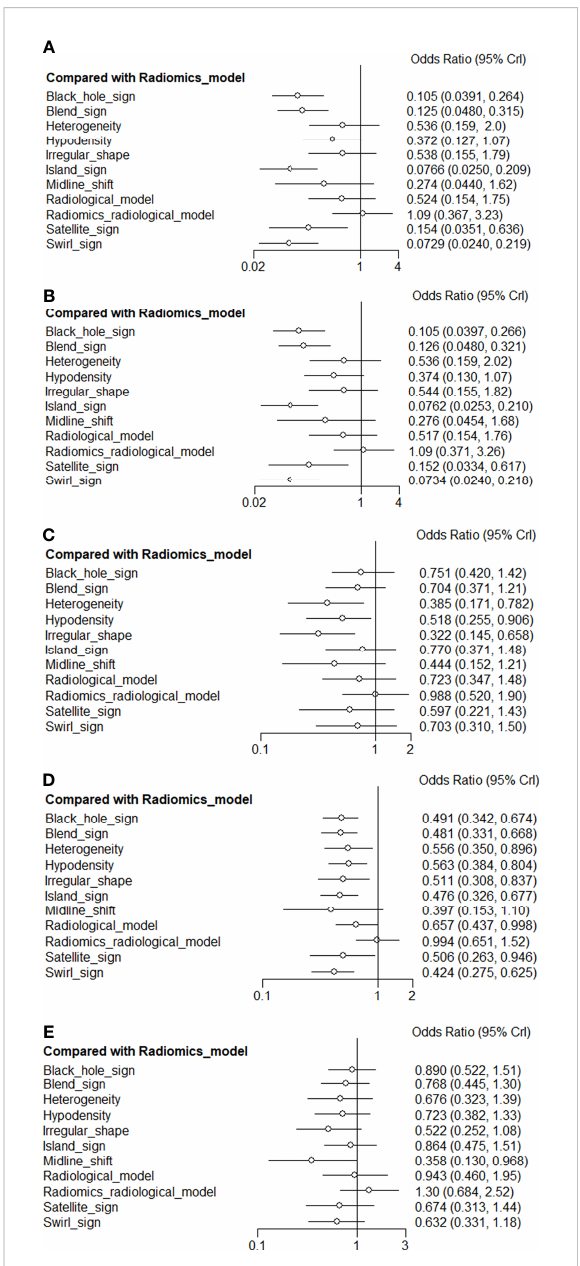
FIGURE 5 Network forest plot for biomarkers compared with radiomics model. Crl: credible